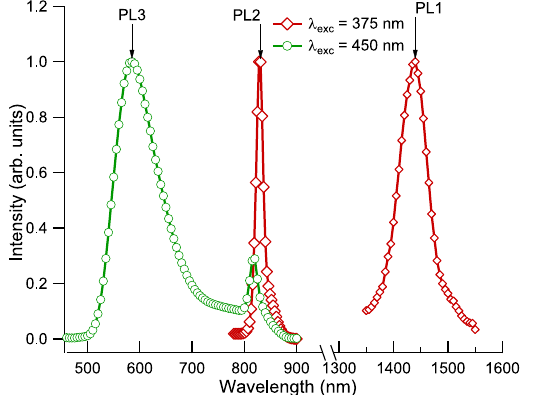
Figure 1. Spectra of luminescence in visible and NIR ranges under different excitation